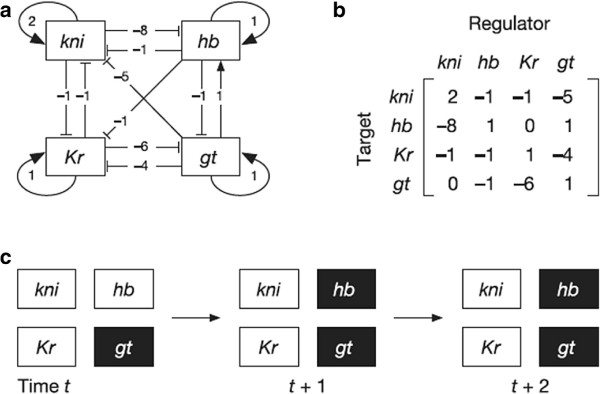
The network model for the gap gene system ofDrosophila melanogaster (reproduced from [20]).(a) Network representation of the regulatory interactions between four gap genes (gt, giant; hb, hunchback; kni, knirps; Kr, Krüppel). (b) Corresponding matrix W. (c) graphic representation of the gene expression states of each gap gene over three successive time steps of a sigmoidal function similar to (3) where a filled box denotes ‘on’ (1), and an open box denotes ‘off’ (−1).